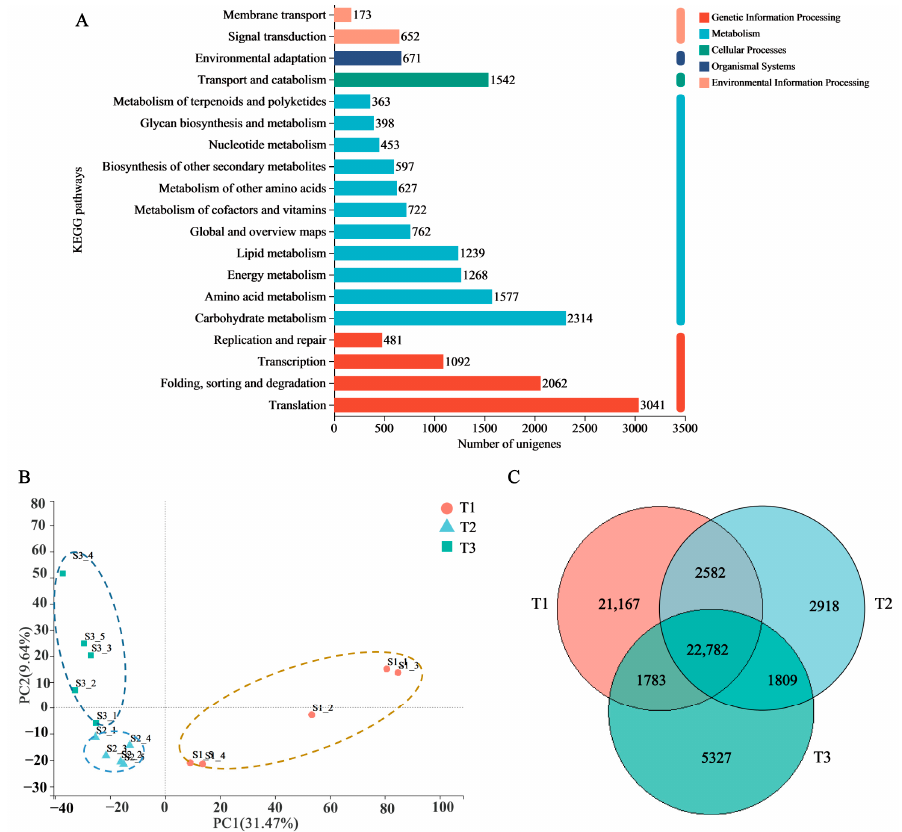
Figure 3. Expression analysis of unigenes in the roots of SYQ at different developmental stages. ( A ) KEGG annotation of unigenes. ( B ) PCA plot showing the clustering of transcriptomes. ( C ) Venn diagram of